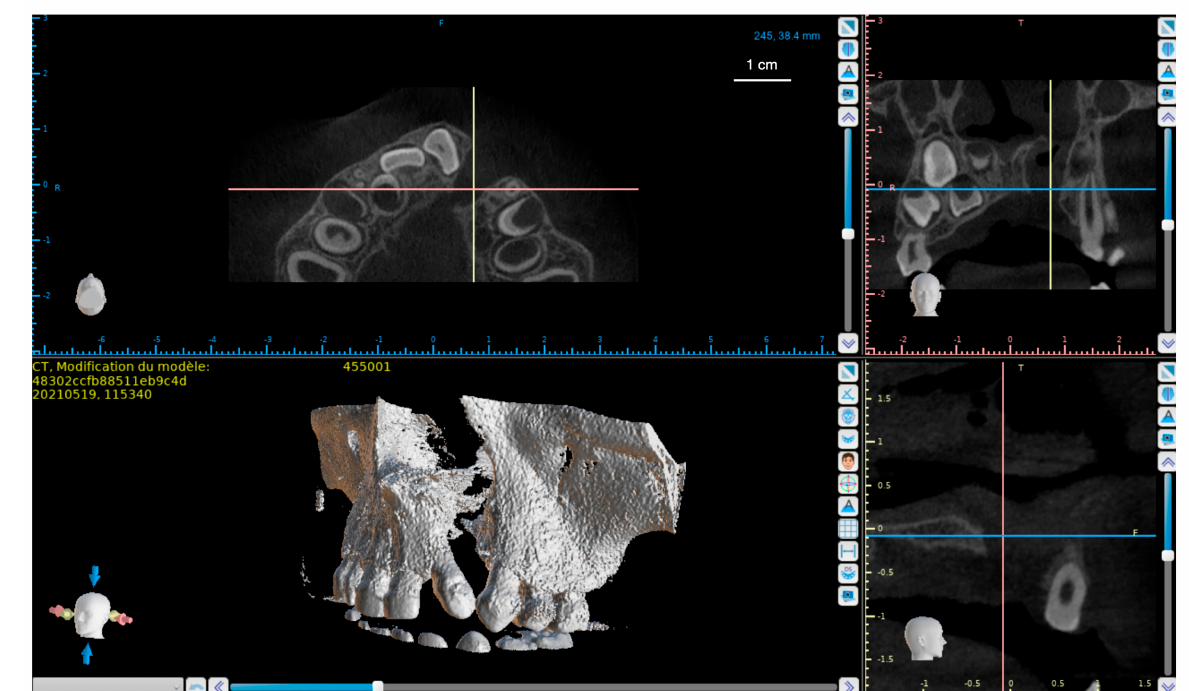
1 Figure 6. Top left : coronal section of a CBCT of a patient with a cleft alveolar-palate. The two fractures are perfectly individualized. Bottom left : volume modeling from DICOM files before export.